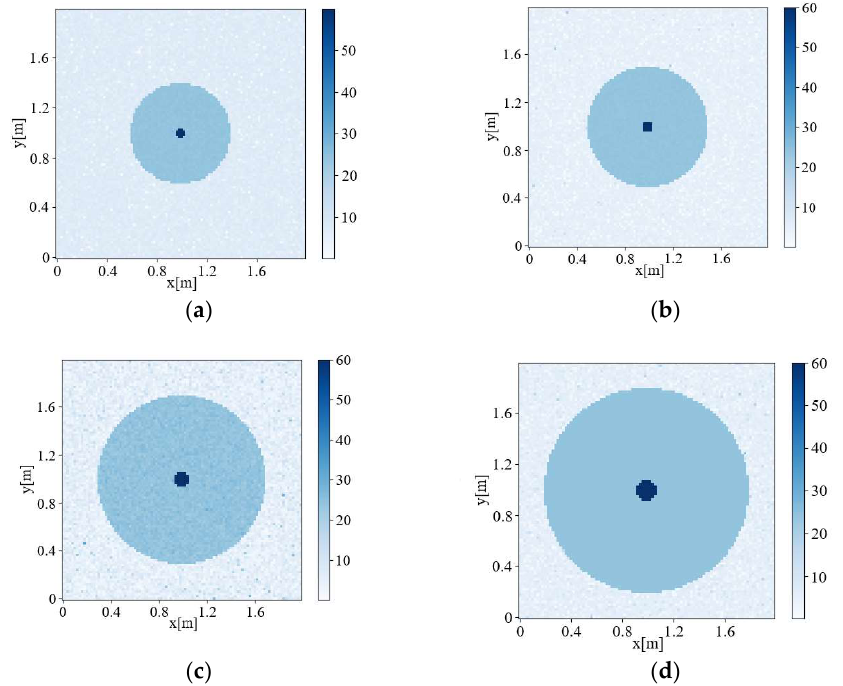
Figure 6. Inversion images with the same inversion ratio and different sizes: ( a ) 0.04 m radius of pest community; 0.4 m radius of the living tree, ( b ) 0.05 m radius of pest community; 0.5 m radius of the living tree, ( c ). 0.07 m radius of pest community; 0.7 m radius of the living tree, and ( d ) 0.08 m radius of pest community; 0.8 m radius of the living tree. Table 3. IOU of each Inversion image when Inversion Ratio =1:10.